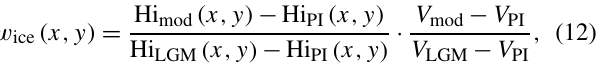
Table 1. Tuned values of the ablation parameter c 3 as used in Eq.